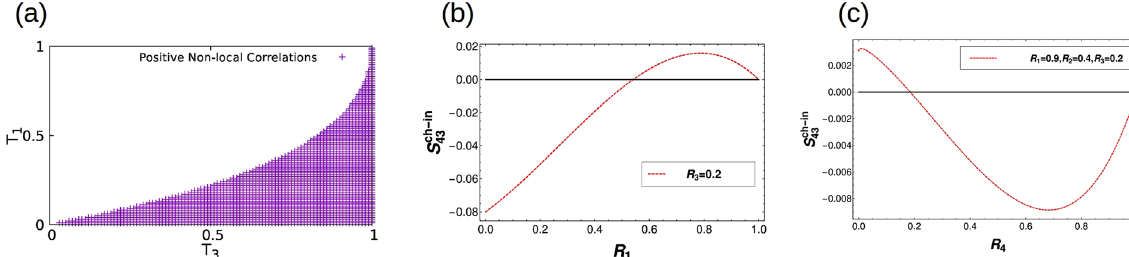
Figure 6. S vs. Disorder. ( a ) Non-local correlation (S 43 ) vs. T 1 and T 3 for two probe disorder with inelastic 43 scattering for QSH (Positive cross correlation), ( b ) Non-local correlation S 43 vs R 1 for two probe disorder with inelastic scattering for QSH with parameters = . R 0 2 , ( c ) Non-local correlation S 43 vs R 4 for all probe disorder 3 with inelastic scattering for QSH with parameters R 1 = 0.9, = . R 0 4 and = . R 0 2 . 2 3